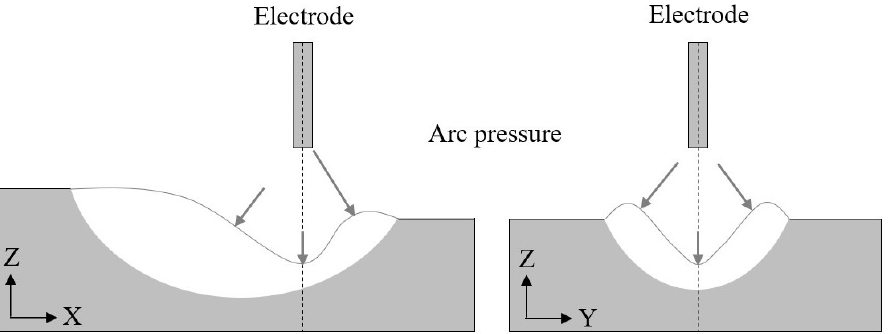
Figure 6. Arc pressure distribution on the surface of the molten pool.